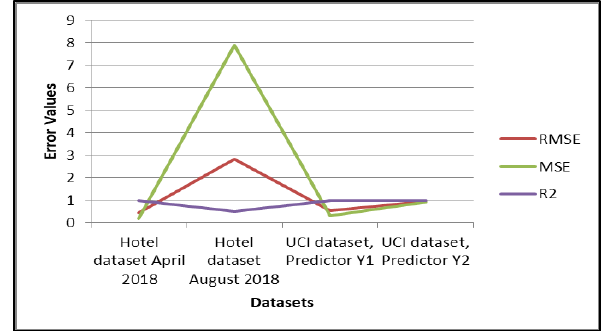
Figure 11. Comparative analysis of both